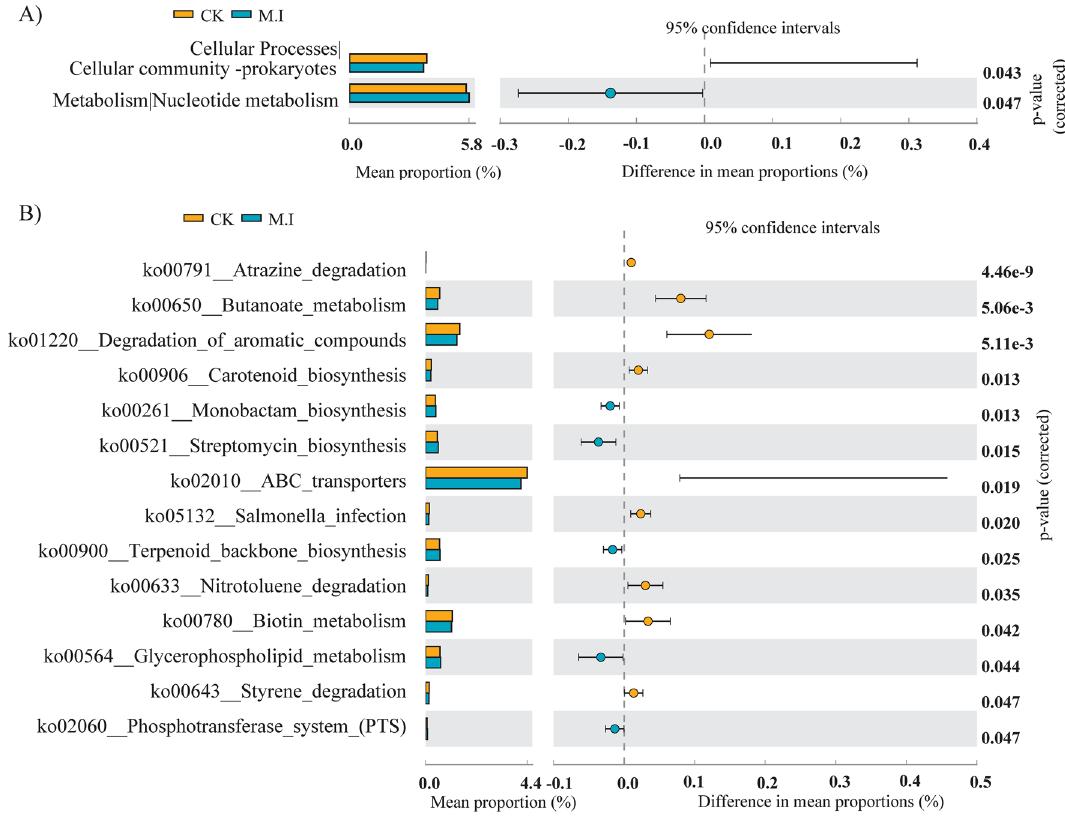
Figure 4. Differential microbial metabolic function of the 2nd tier ( A ) 3rd tier ( B ) KEGG in soil of the pristine forest forests and M. micrantha -invaded forest.